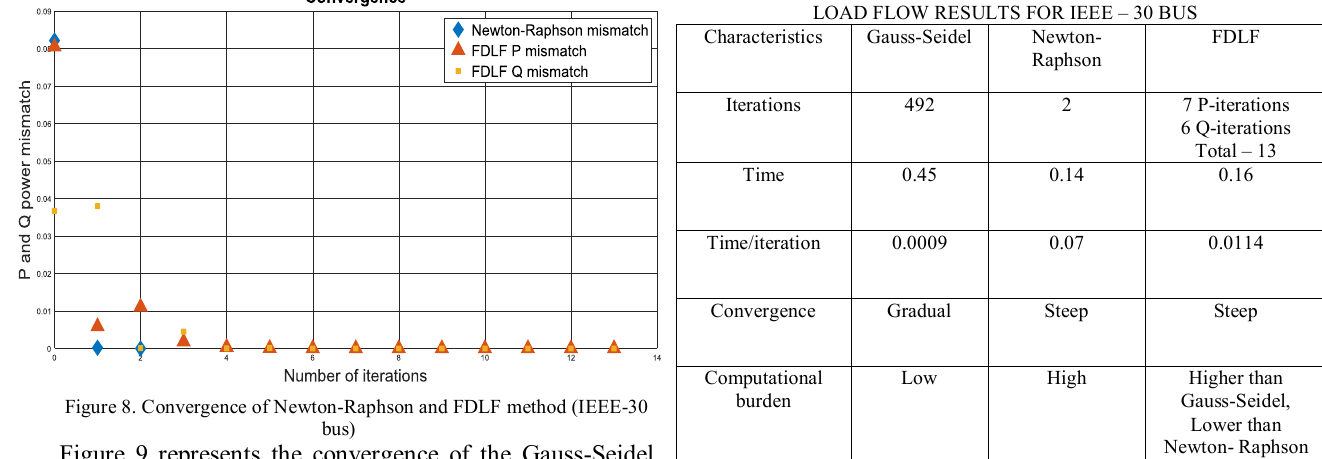
Figure 8. Convergence of Newton-Raphson and FDLF method (IEEE-30 bus)